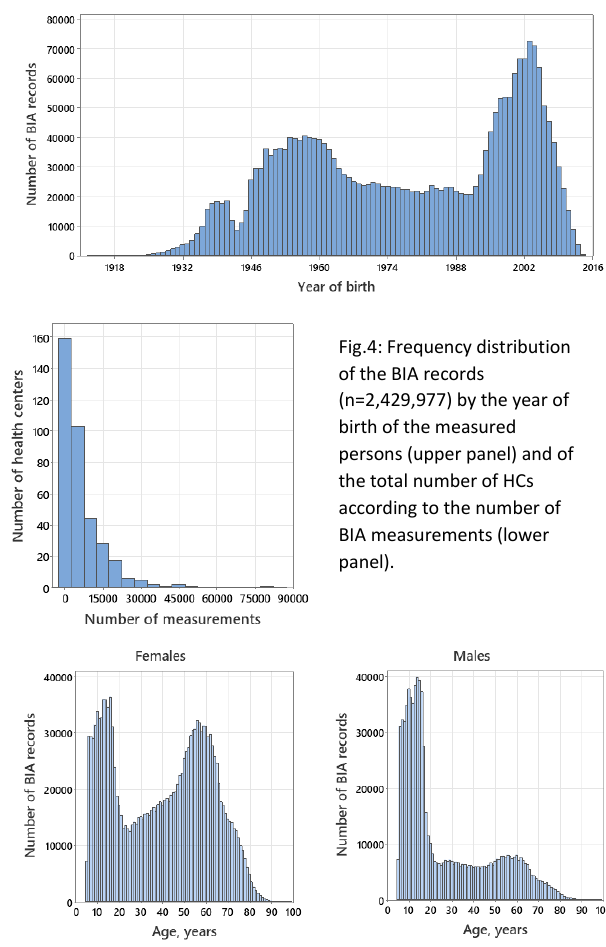
Fig.5: Age structure of the measured persons: left – females (n=1,607,906), right – males (n=822,071). School-age children were examined in HCs most often, with the total number of boys slightly higher than that of girls (figure 5). After the school age, the number of examinations per year of age decreased sharply, and the rate of BIA measurements was dominated by females. The peak rate of the measurements among adults fell on a subgroup of women aged 50-65 years.